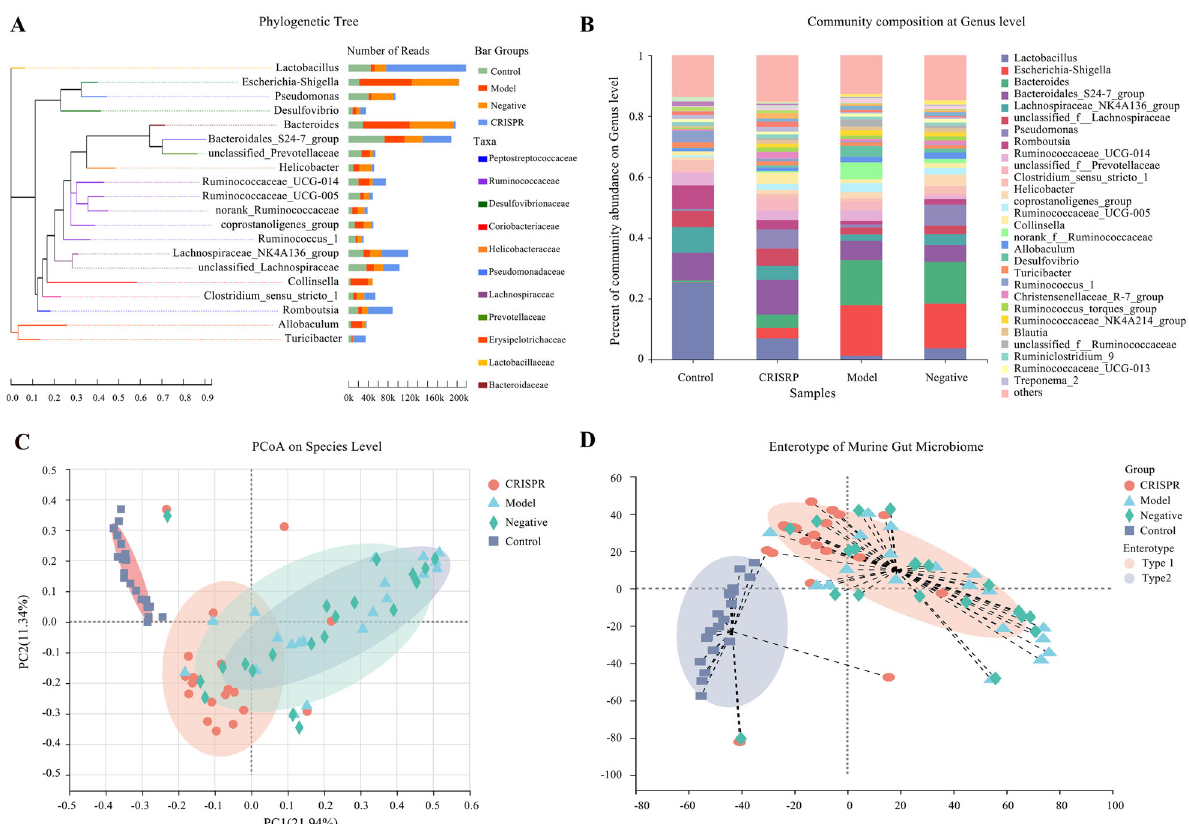
Fig. 5 The gut microbiota composition of the CRISPR group tends to restore to an equilibrium status, similar to the control. A Phylogenetic tree of the samples with number of reads per genus showed Escherichia – Shigella has the highest abundance, followed by Bacteroides , Bacteroidales S24-7 group, and Lactobacillus . B Microbial community composition of the CRISPR group was apparently differed from that of the model group and was close to that of the control. C Samples were presented on a PCoA plot at species level and were grouped by eclipses with 95% con fi dence. Three distinguishable groups were identi fi ed, the CRISPR group was intersected with the model group and the control. D Two cognizable enterotypes were identi fi ed, type 1 mainly consisted of the model group and type 2 mostly included the control. Interestingly, samples in the CRISPR group belonged to both type 1 and type 2. Fecal samples were collected from 32 rats with CCl 4 -induced liver fi brosis and 20 normal rat (the control). Fecal samples collected before injection of RSPO4-CRISPR were noted as the model group, and samples collected after the injection of RSPO4-CRISPR were noted as the CRISRP